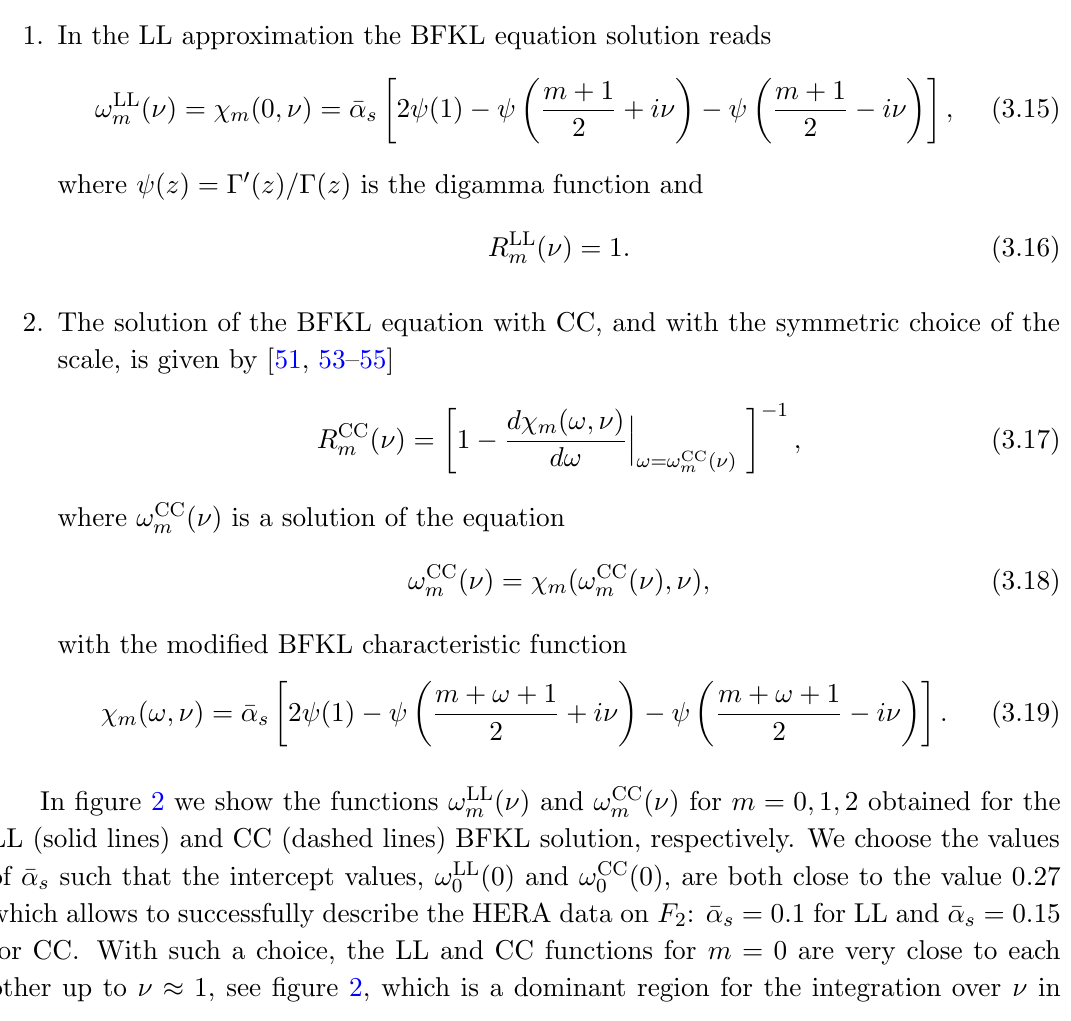
Figure 2 . The functions ! LL and (3.18), respectively, for m = 0 ; 1 ;